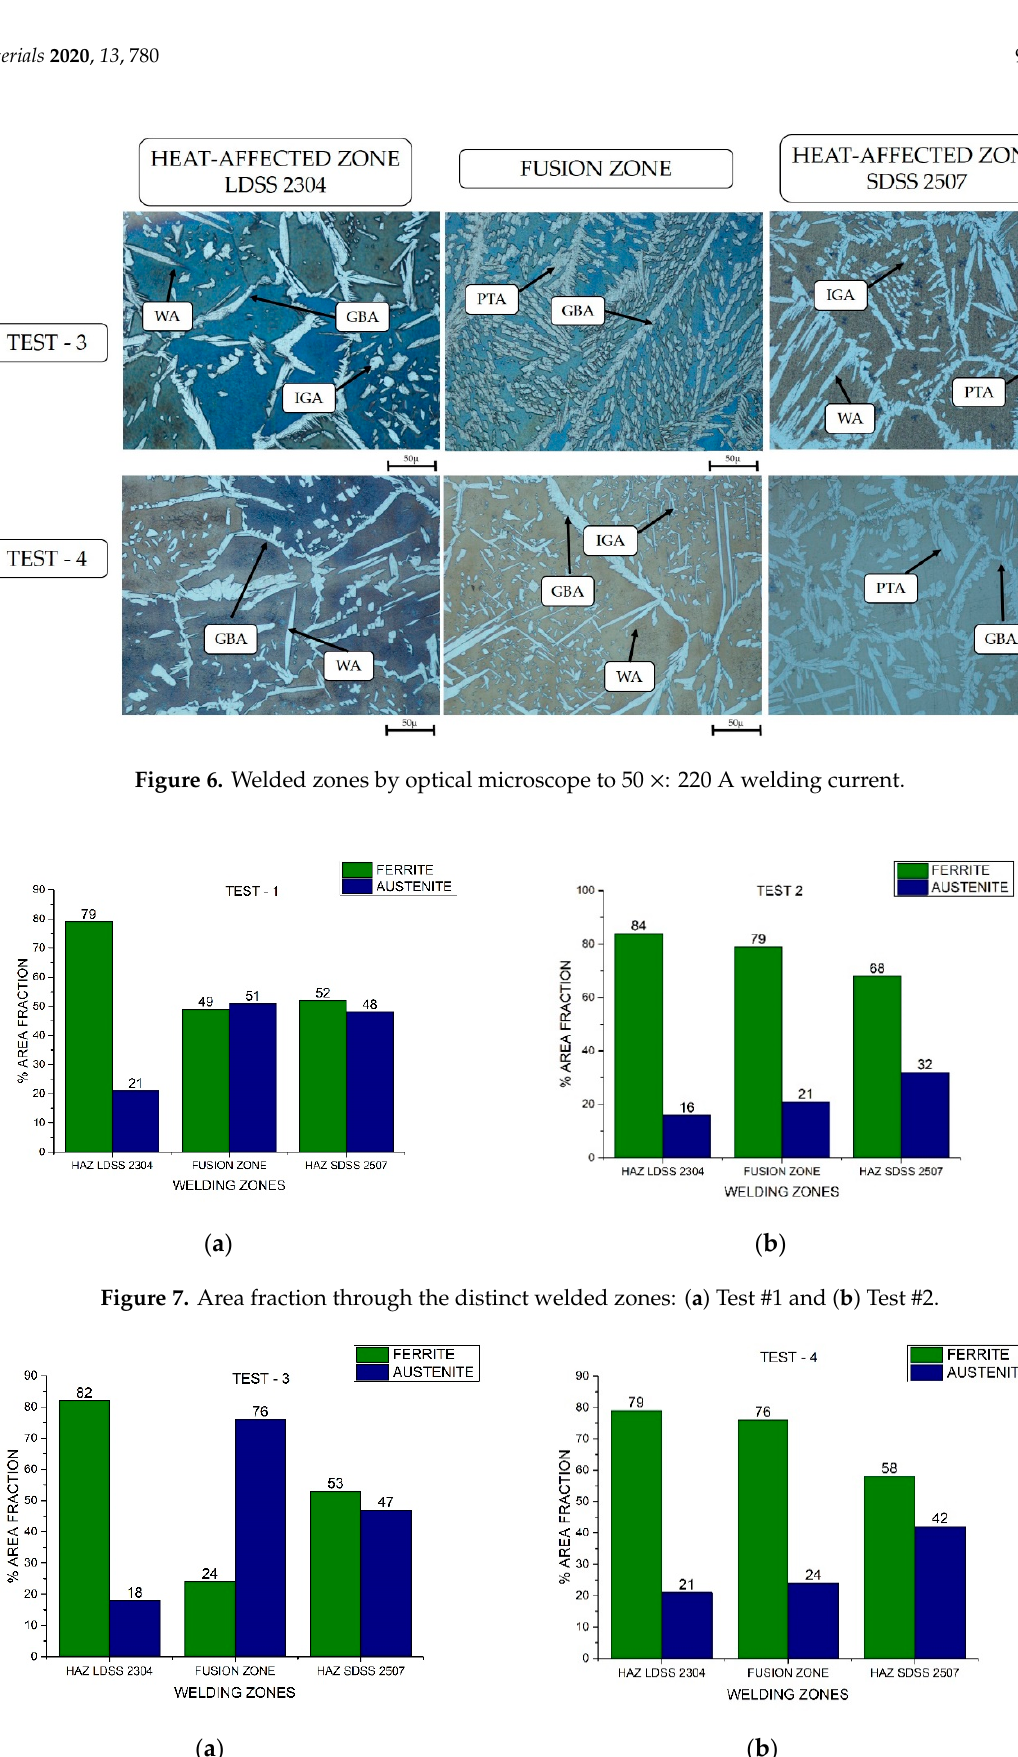
Figure 8. Area fraction through the distinct welded zones: ( a ) Test #3 and ( b ) Test #4.